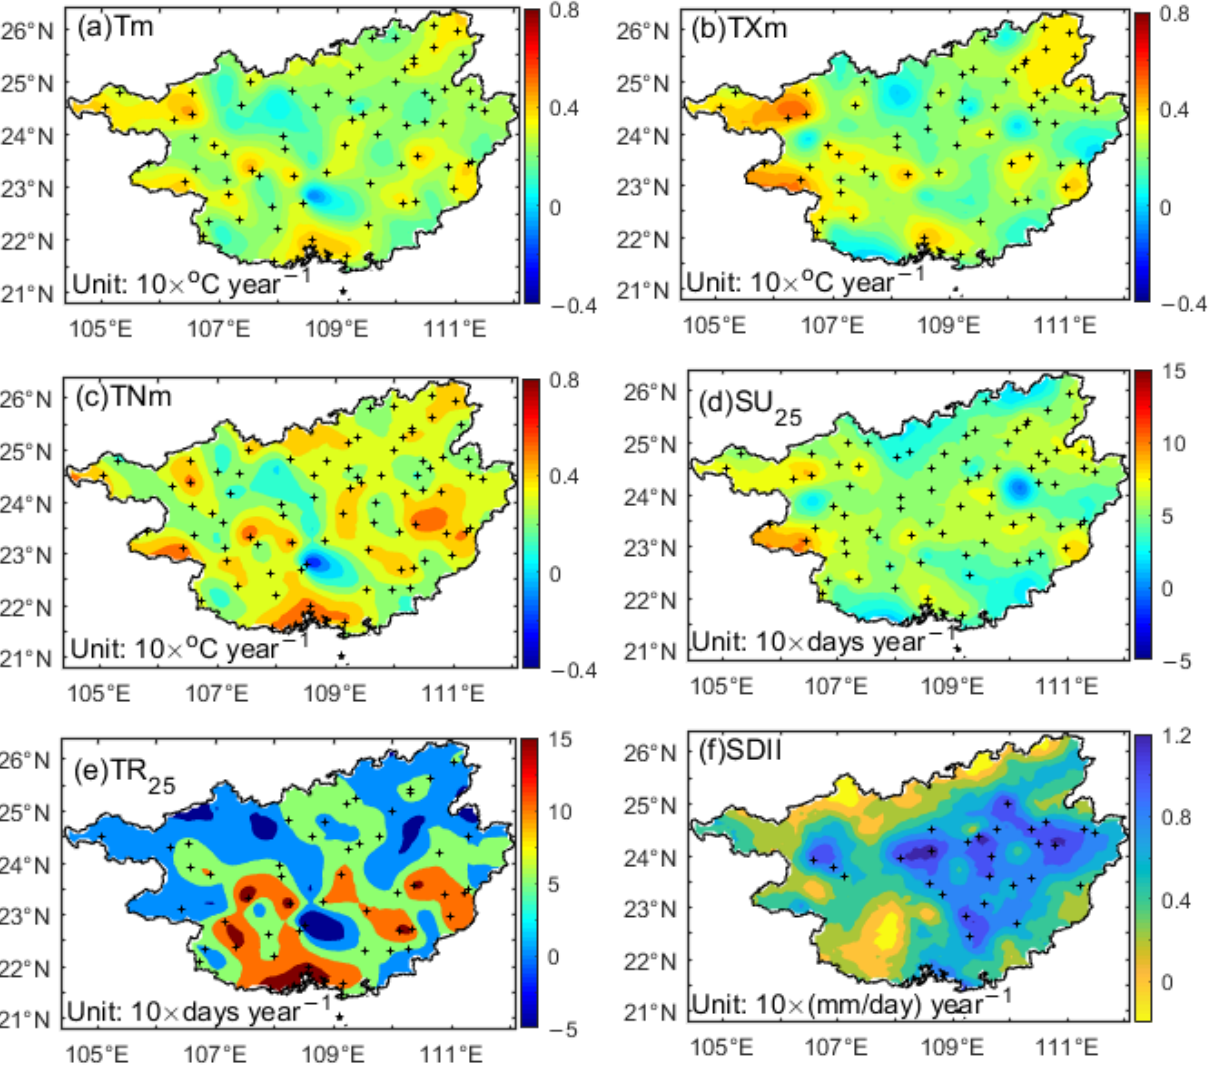
Figure 10. Spatial distributions of the trend rates of the annual climate indices during 1982–2015: ( a ) TXm, ( b ) TNm, ( c ) TXx (unit: 10 × °C year − 1 ); ( d ) SU 25 , ( e ) TR 25 (unit: 10 × days year − 1 ) and ( f ) SDII (unit: 10 × (mm/day) year − 1 ). Note: ‘+’ significant at p < 0.05.